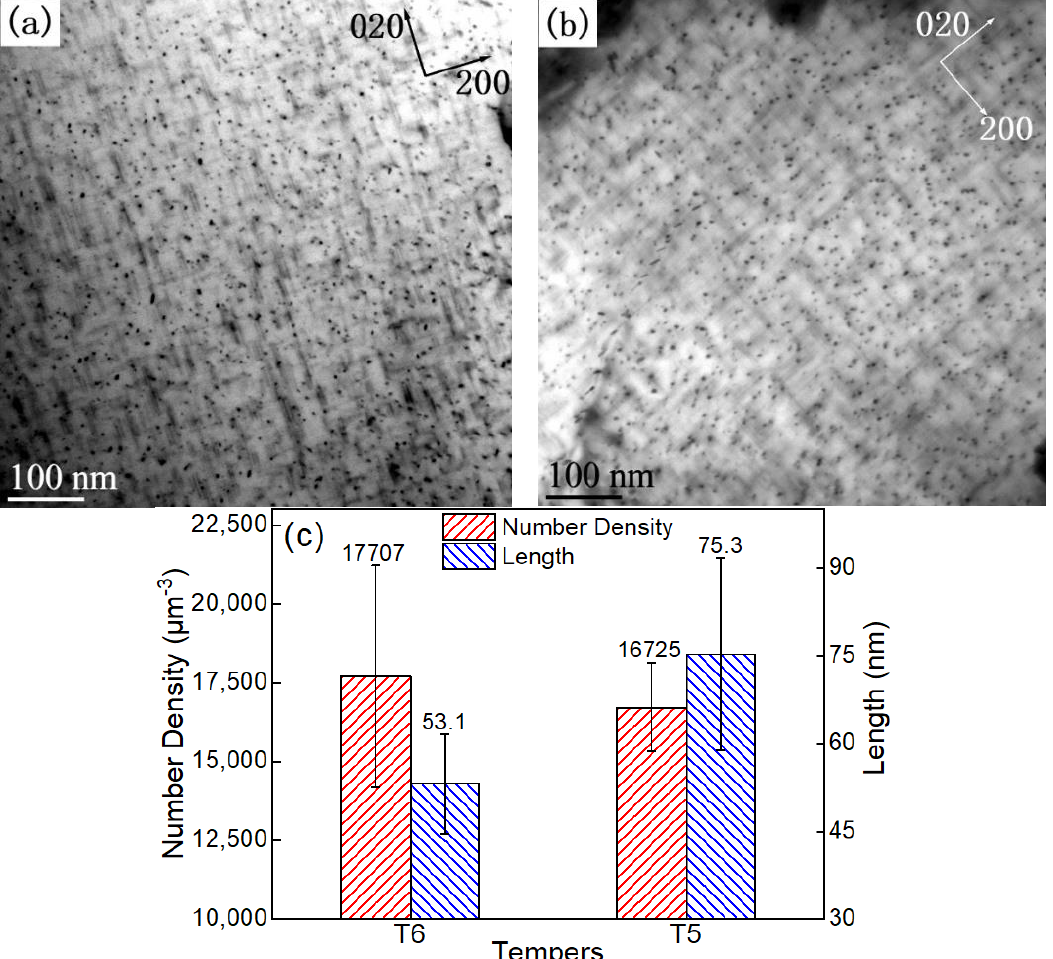
Figure 12. Precipitations after ( a ) T5 and ( b ) T6 treatments and their characteristics ( c ) in extruded AA6082 alloy.